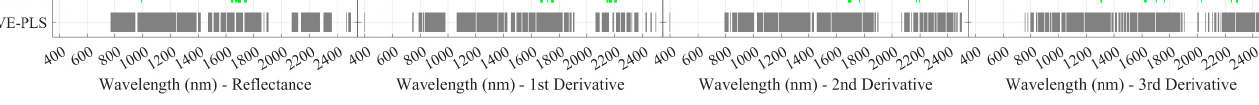
Figure 7. Distribution of bands selected with different band-selection methods for LNC estimation from combined spectra (reflectance, 1st, 2nd, and 3rd derivatives) within 400–2500 nm.